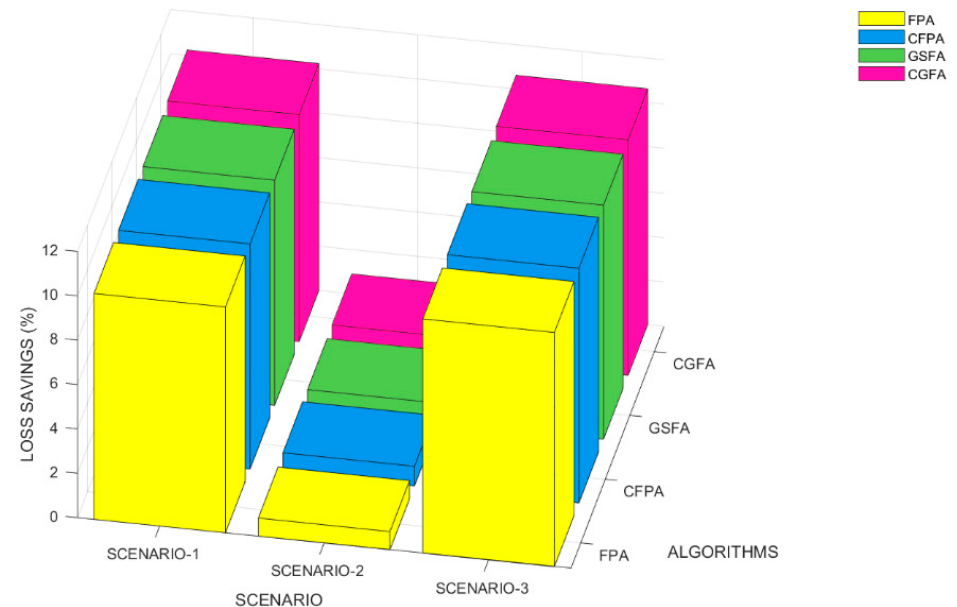
Figure 5. Percentage loss savings of different algorithms in an IEEE 33-bus system.